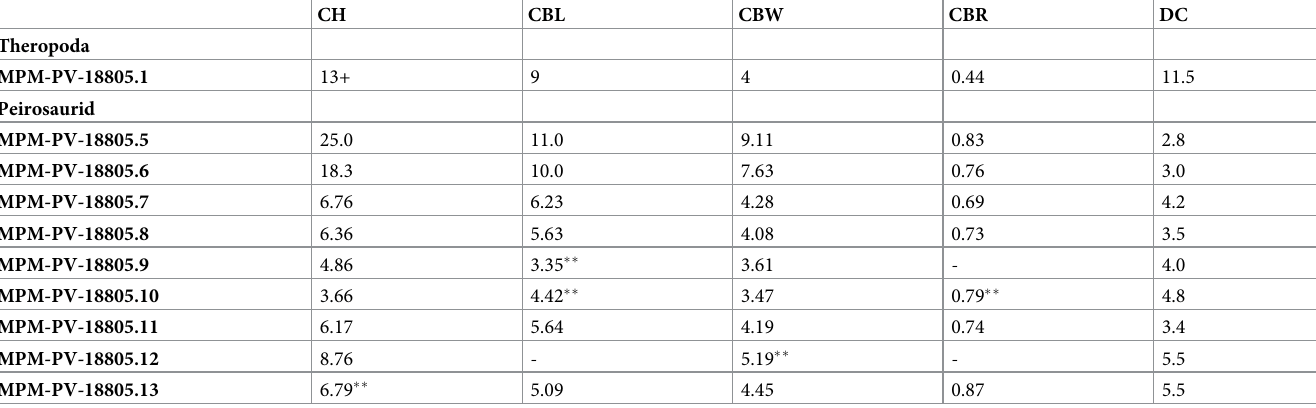
Abbreviations: CBL, crown base length measured at the base of the crown from its mesialmost to distalmost extention (excluding the carinae); CBR, crown base ratio, numeral value derived from dividing CBW and CBL (= labiolingual compression); CBW, crown base width, labiolingual extension of the crown at its base; CH, crown height; DC, denticle density (per 5 mm in theropods; per 1 mm in crocodyliforms). � at mid-crown. �� partial